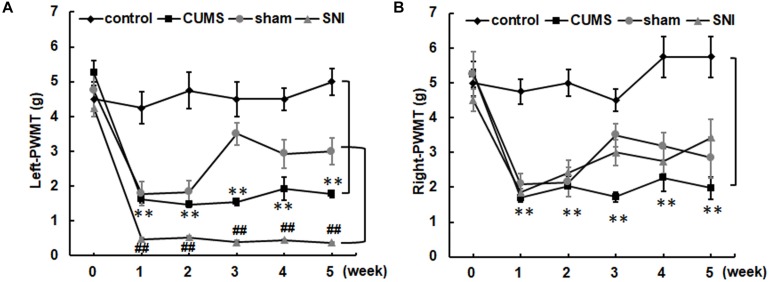
The left (A) and right (B) paw withdrawal mechanical thresholds of the four groups. Data are shown as mean ± standard error (M ± SEM). N = 8. **p < 0.01 vs. control group. ##p < 0.01 vs. SNI-sham group.